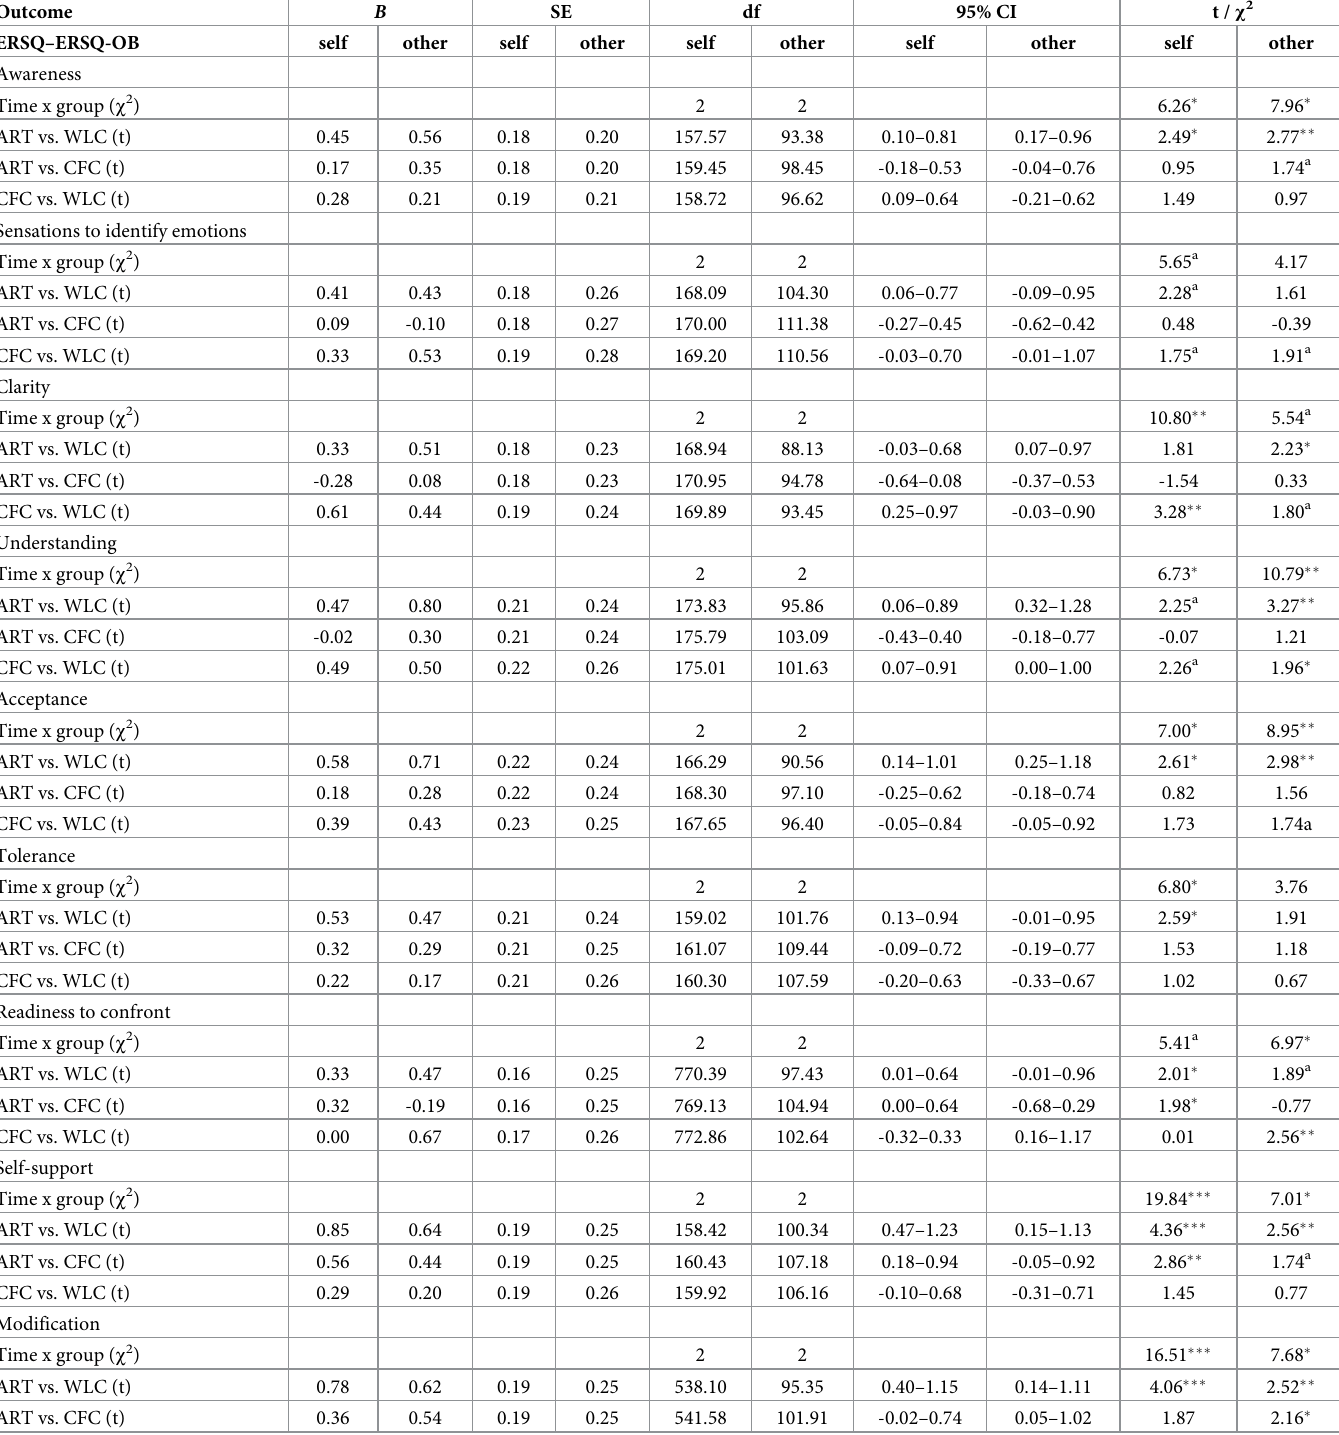
Table 4. Cross-level interaction effects and pairwise comparisons between groups for emotion regulation subscales